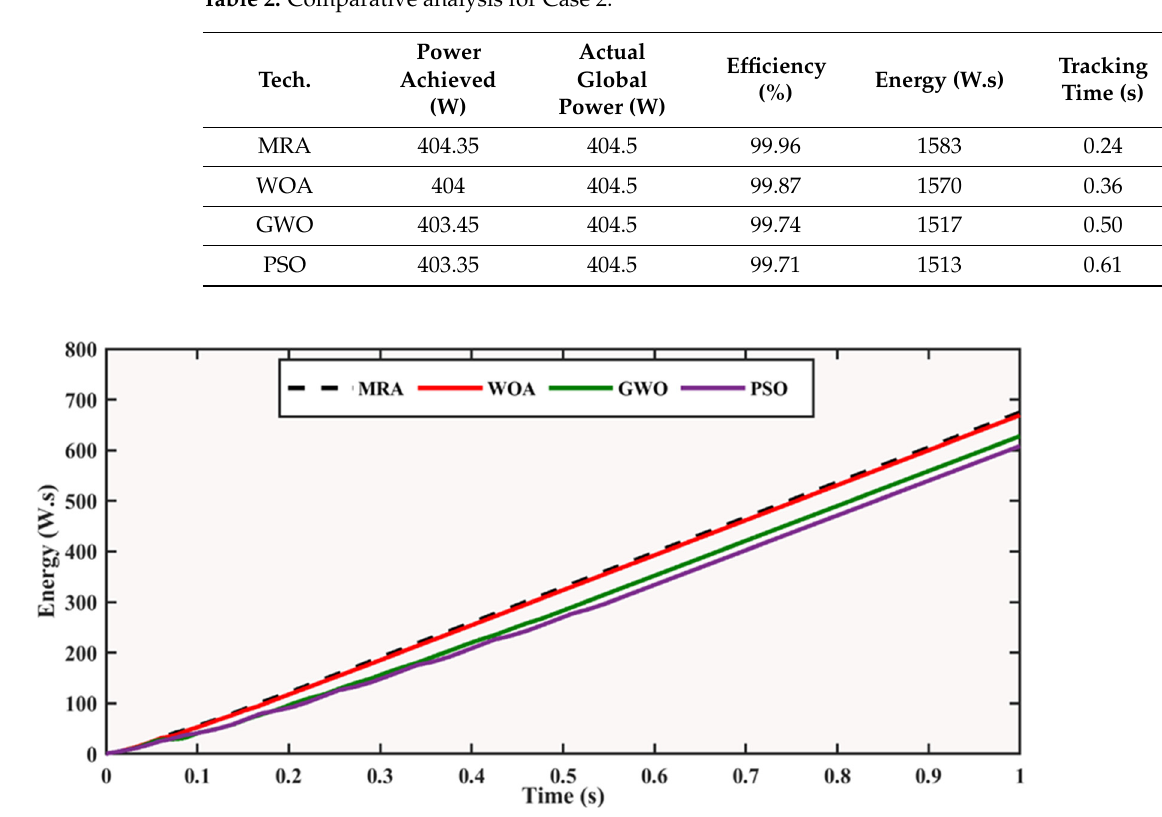
Table 2. Comparative analysis for Case 2.